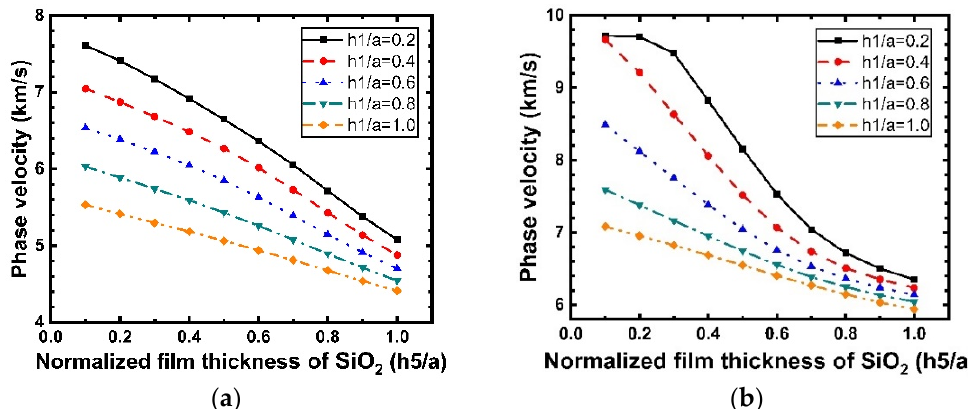
Figure 13. Dispersion curves of the Rayleigh and Sezawa waves velocity calculated for various values of h 5 / a for the structure SiO 2 /IDT/ LiNbO 3 /diamond/Si. ( a ) Rayleigh mode; ( b ) Sezawa mode.